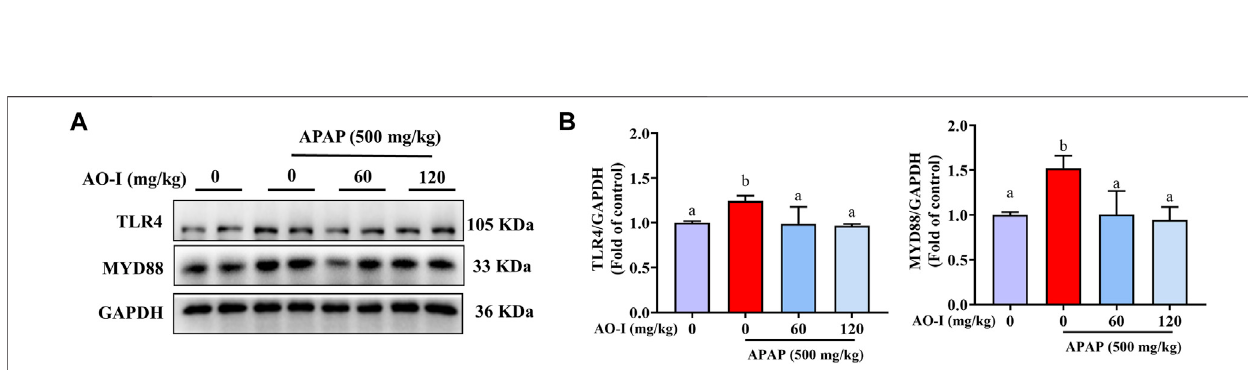
FIGURE 4 | AO-I inhibits APAP-induced TLR4 signaling pathway. (A) Effects of AO-I on APAP-induced TLR4 and MYD88 expression in the liver. (B) Quantitative map of TLR4 and MYD88 protein expression. All data are presented as the mean ± SEM. Bars with different characters present statistically signi fi cant results, p < 0.05.